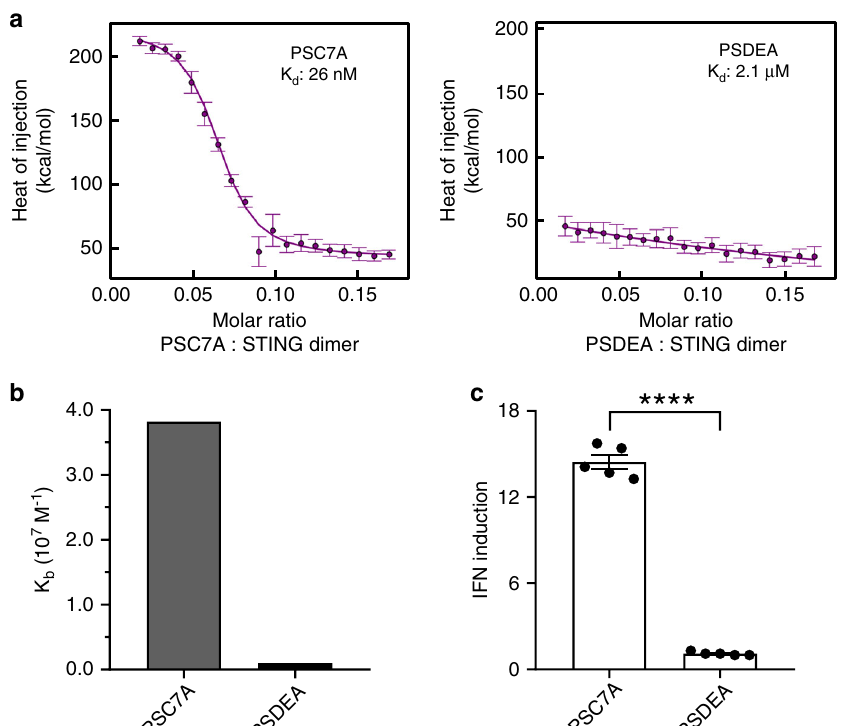
Fig. 2 Stimulator of interferon genes (STING) binding and activation by the PSC7A polymer. a Isothermal titration calorimetry (ITC) analysis shows the PSC7A copolymer has a much higher binding af fi nity to STING than PSDEA. K d : apparent dissociation constant. The error bars are estimates of the integration error based on the noise in the baseline regions fl anking each injection. b Summary of K b values (binding af fi nity, K b = 1/ K d ) of PSC7A and PSDEA to STING from ITC experiments. c Interferon (IFN) induction levels of THP1-ISG cells incubated with PSC7A or PSDEA (0.5 μ M for 48 h) correlate with STING binding af fi nity. n = 5 experimental replicates in each group. Data are presented as means ± s.e.m. and statistical signi fi cance was calculated using Student ’ s two-tailed t test (PSC7A vs. PSDEA: **** P < 0.0001). Results from additional dUPS polymers are presented in Supplementary Fig.